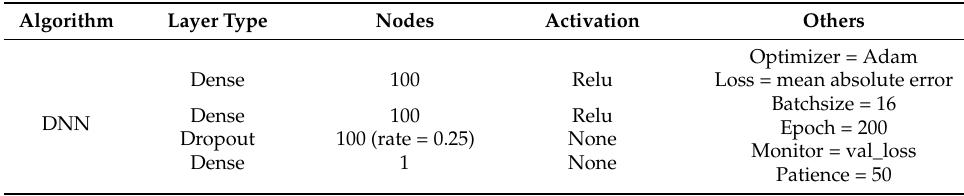
Table A1. The details of the DNN and LSTM